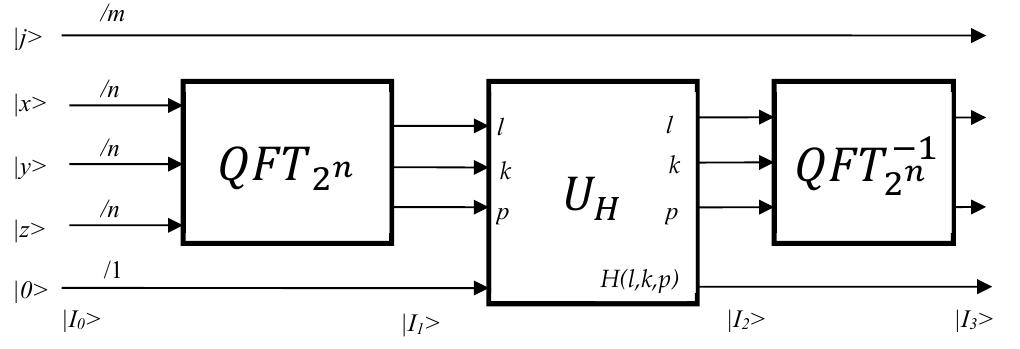
Figure 11. Implementation of the quantum circuit for 3D filtering.